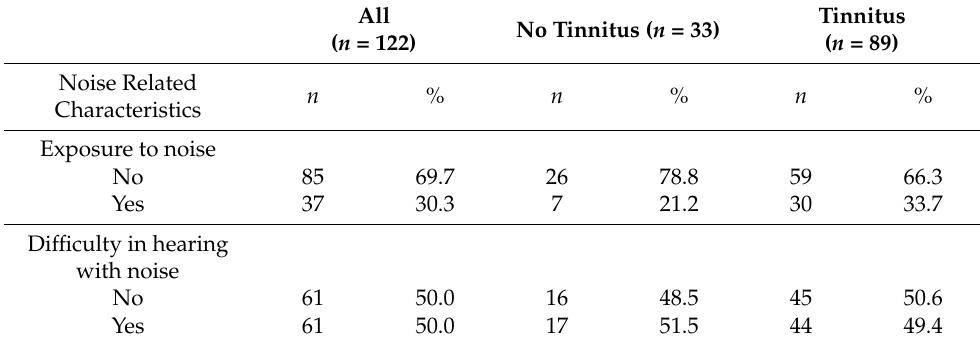
Table 2. Noise related characteristics.